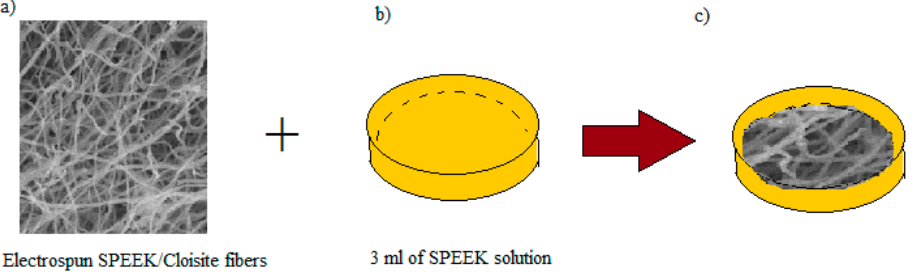
Table 1. The designation of membrane samples.